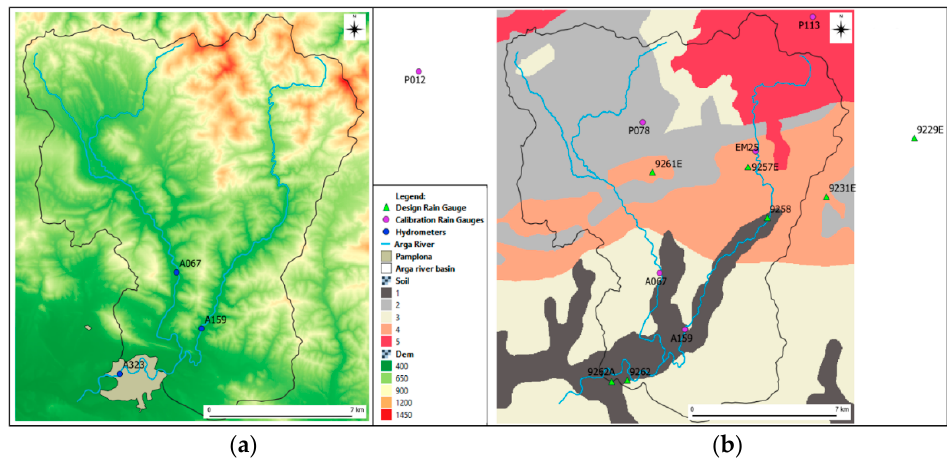
Figure 2. ( a ) Digital elevation model (DEM) and location of streamflow gauges. ( b ) Soil types and location of rain gauges.